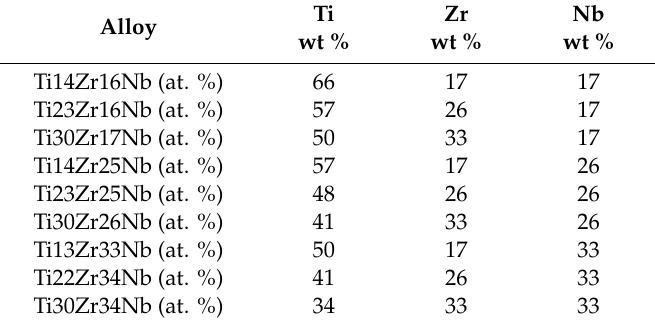
Table 1. Chemical compositions of output powders needed to get following Ti-Nb-Zr alloys after all stages of specimen preparation by the application of SPEX 8000 Mixer Mill (total weight of milling powders: 4.5 g; ball-to-powder mass ratio: 7.5:1; milling time: 10